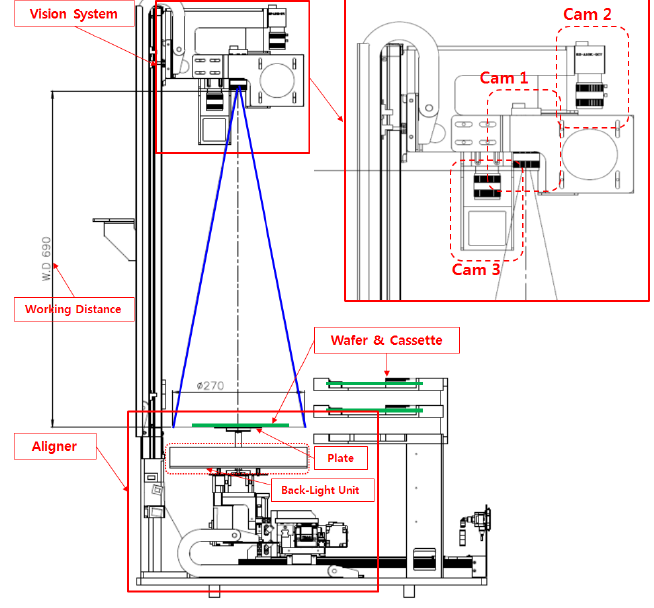
Figure 4. Vision aligner for wafer positioning and angle correction.